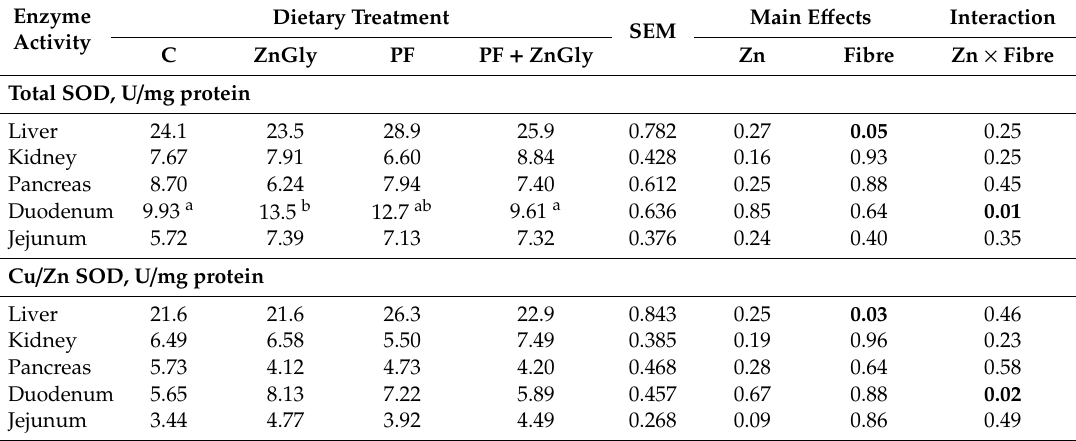
Table 5. Activity of total superoxide dismutase (SOD), Cu / Zn superoxide dismutase (Cu / Zn SOD) and